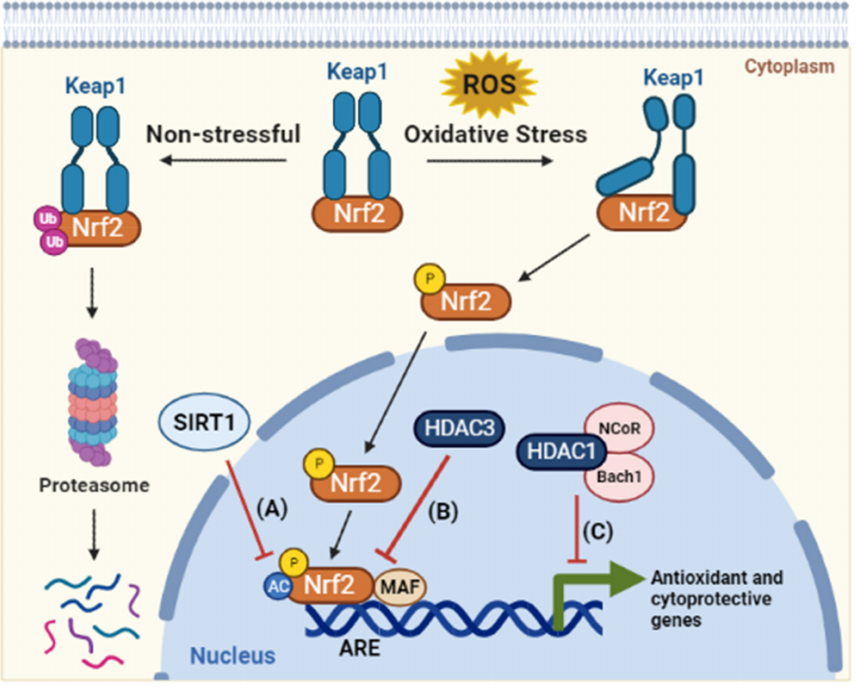
Figure 4. HDACs coordinate the cellular response to oxidative stress. HDACs coordinate the cellular response to oxidative stress. As a defense mechanism against oxidative stressors, Nrf2 acts as a redox-sensitive transcription factor. Under homeostatic conditions, Keap1 sequesters Nrf2 in the cytoplasm, resulting in its degradation by proteasome. When the cells are subjected to oxidative stress, Nrf2 is activated through its dissociation from the Keap1 complex. Then, the Nrf2 protein is transported to the nucleus, where it is acetylated and dimerized with the MAF protein at the antioxidant reactive element (ARE) site in the promoters of antioxidant genes. Through this process, antioxidant genes are activated to scavenge excess reactive oxygen species (ROS) and maintain mitochondrial function. In response to oxidative stress, HDACs act as a negative regulator of the Nrf2 pathway. ( A ) SIRT1 inhibits Nrf2 acetylation, which reduces its binding to ARE and thereby obstructs Nrf2-mediated gene expression. ( B ) HDAC3 is recruited to the ARE site and induces a histone hypoacetylation state, hence repressing ARE-dependent gene expression. ( C ) HDAC1 forms a complex with Bach1, which competes with Nrf2 for the binding to transcription cofactor MAF in oxidative-stress-response genes. Bach1 acts as a functional inhibitor of Nrf2 by forming a complex with nuclear co-repressor NCoR. Abbreviations: Nrf2, NF-E2–related factor 2; Keap1, Kelch-like ECH associated protein 1; ROS, reactive oxygen species; MAF, musculoaponeurotic fibrosarcoma; ARE, antioxidant responsive element; Bach1, BTB domain and CNC homolog 1; NCoR, nuclear receptor corepressor